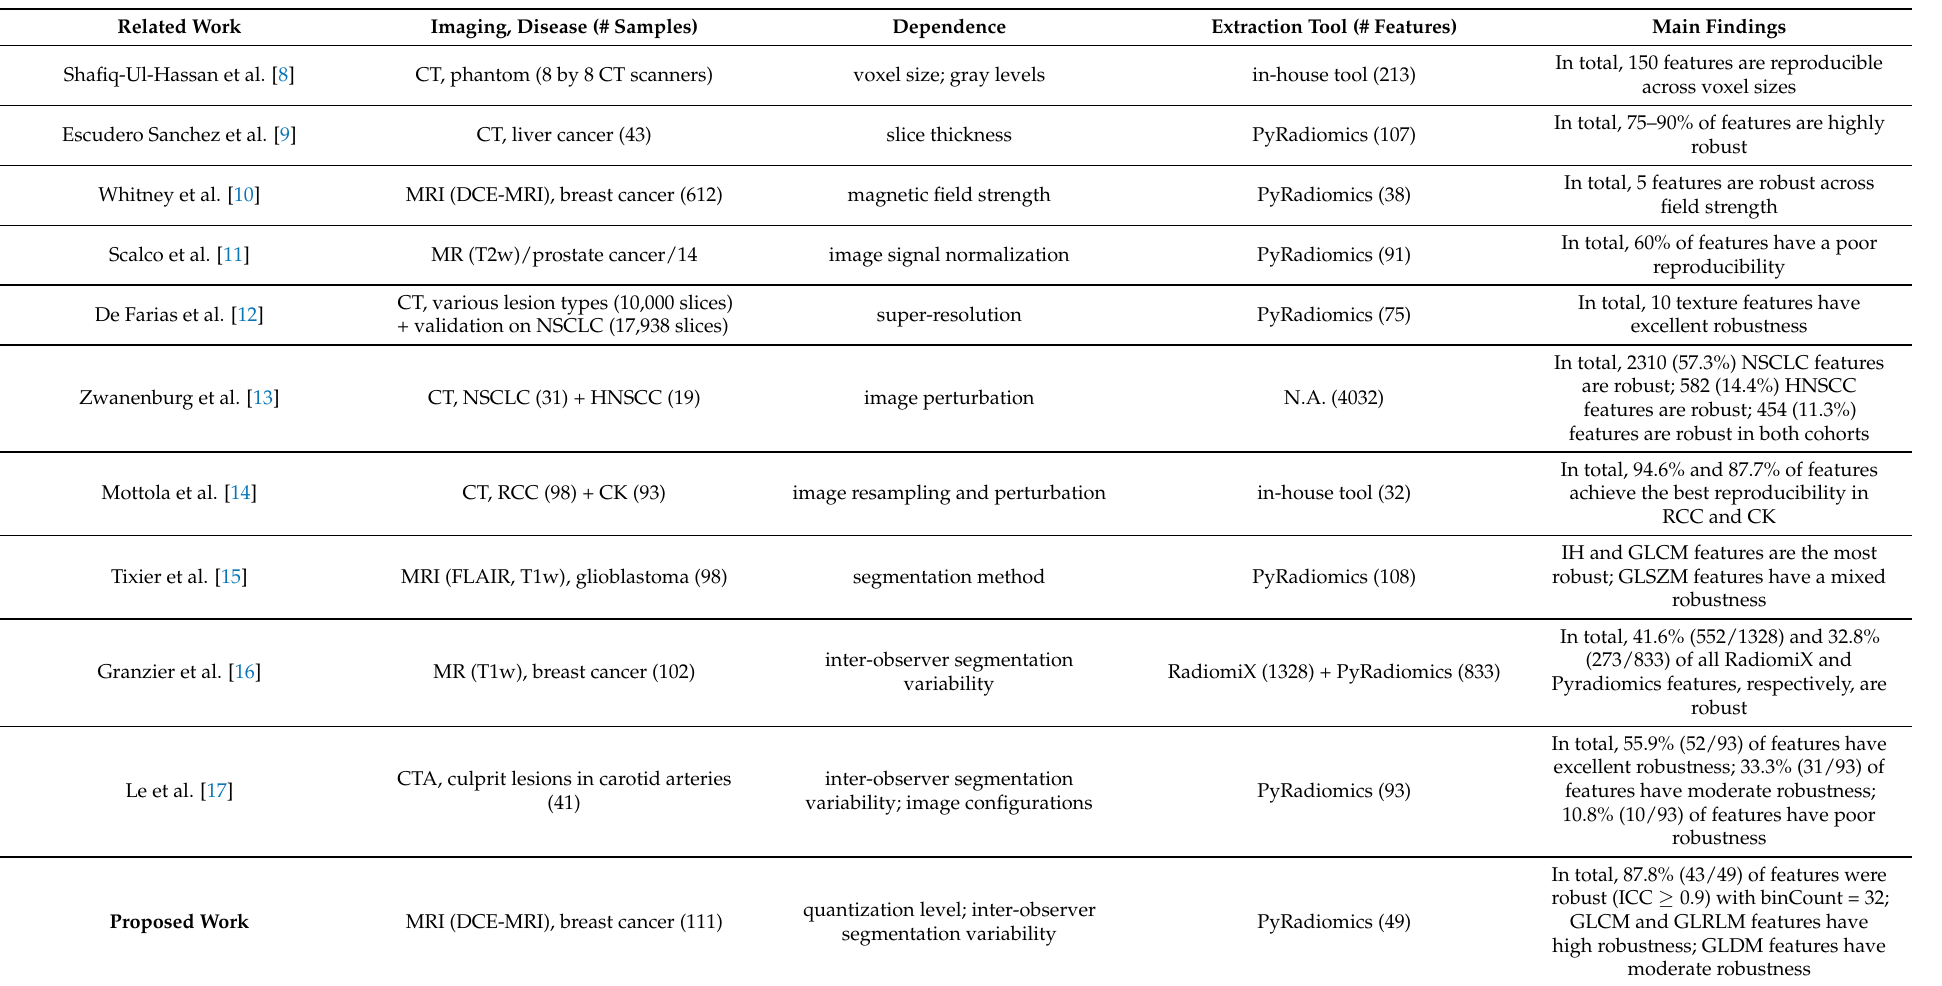
Table 6. Overview of the state-of-the-art results, along with the considered settings, to assess the robustness of radiomic